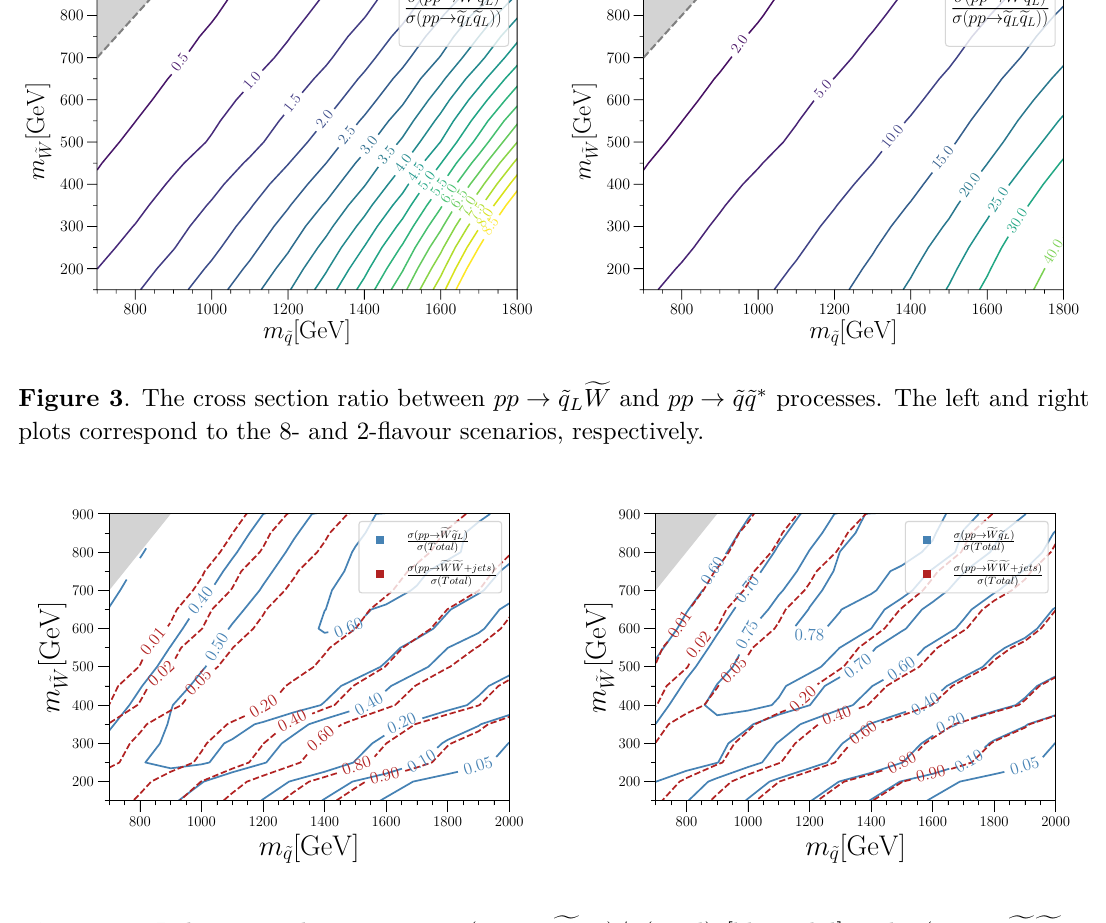
W ˜ q L ) /σ (total) [blue-solid] and σ ( pp → W ˜ q L , W W + ISR) . The cross section of ˜ q L ˜ q L , → f f f f